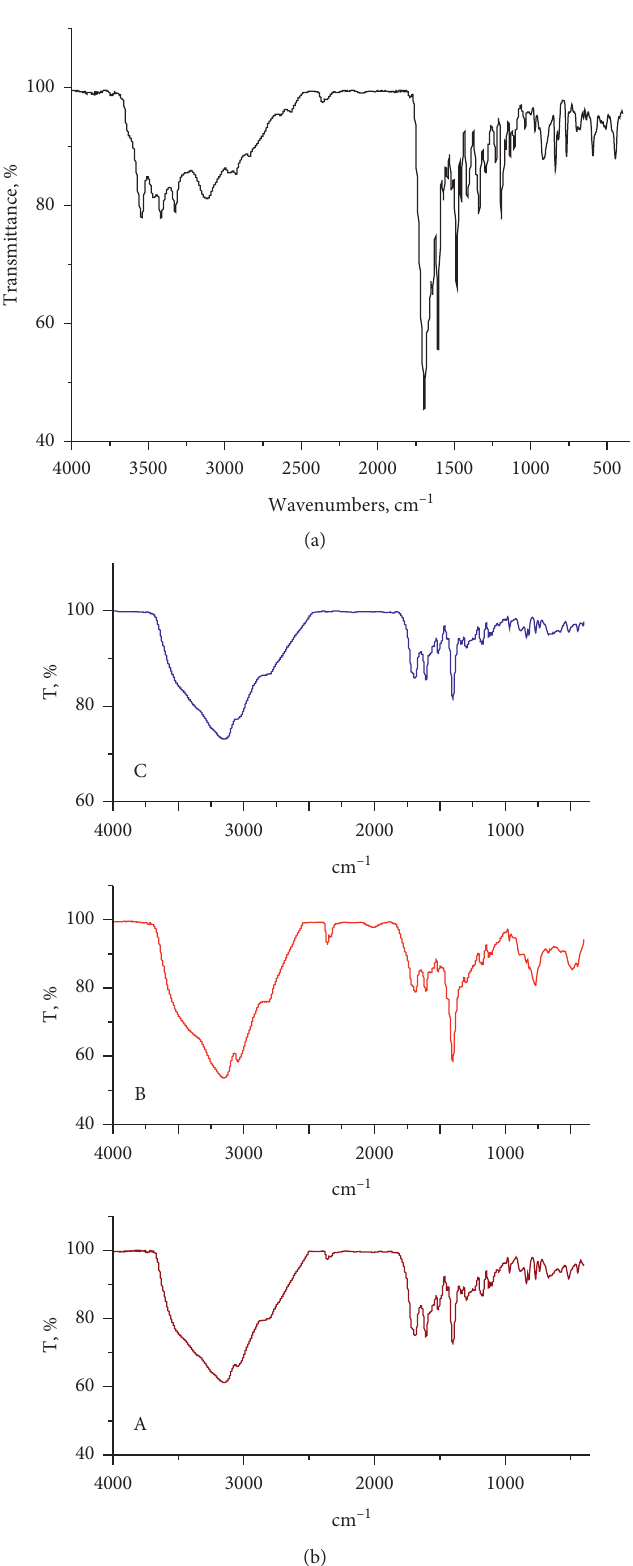
Figure 2: (a) Infrared spectrum of a pure folic acid drug; (b) infrared spectra of A :Ga(III), B :Ge(IV), and C :Hf(IV) folate